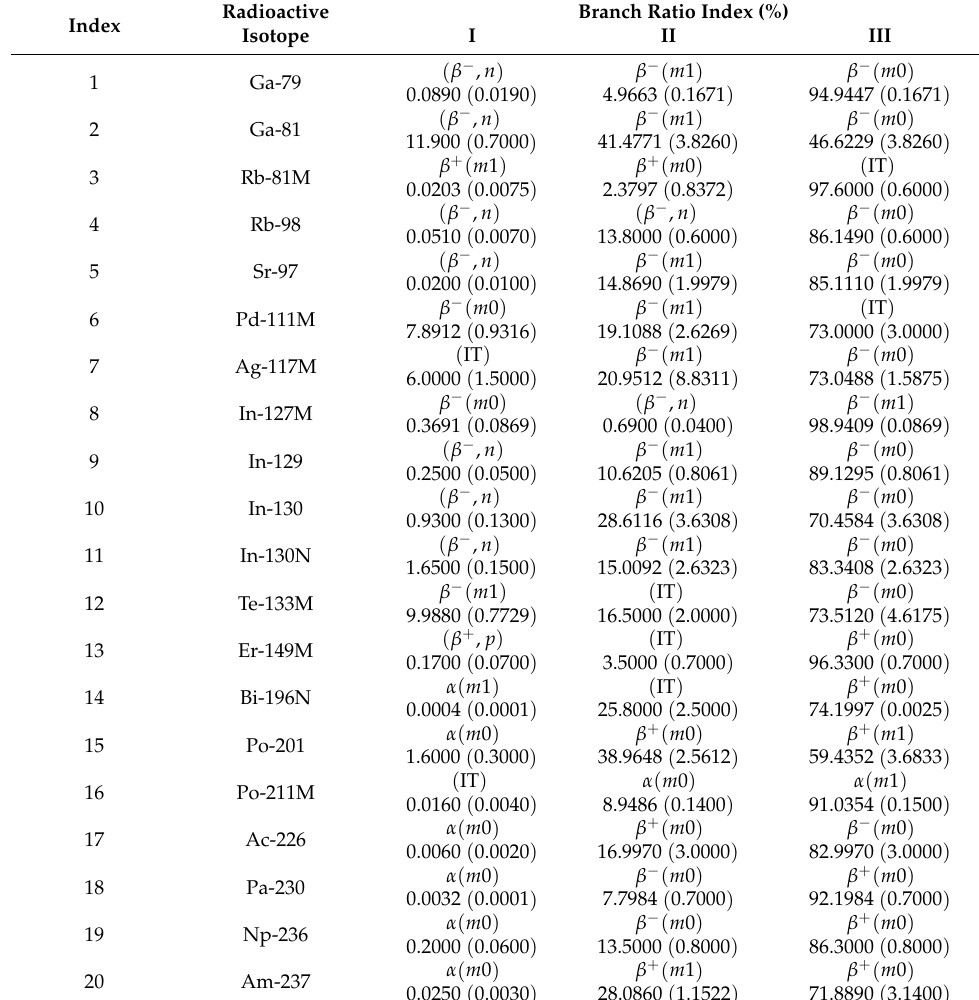
Table A1. Branch ratio data from